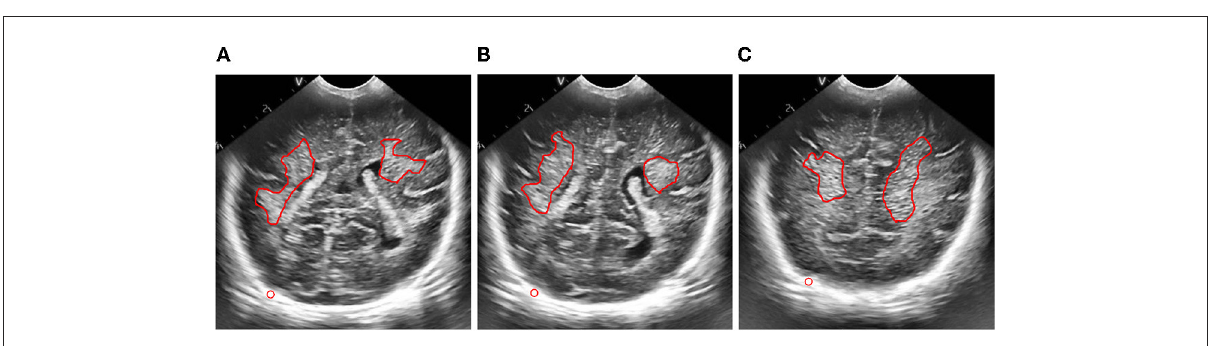
FIGURE10 Figure of result of frame selection of regions of interest and reference regions. (A) Plane 1, (B) plane 2, (C) plane